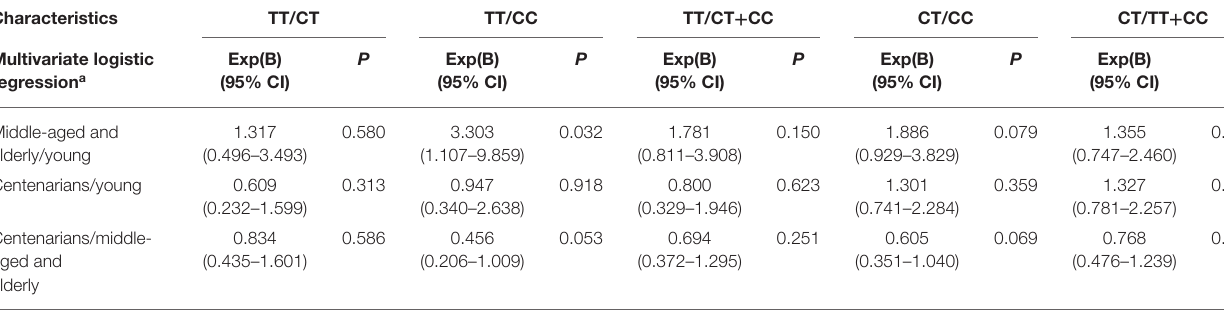
TABLE 2 | Associations of age group with different genotypes of rs189037. Characteristics